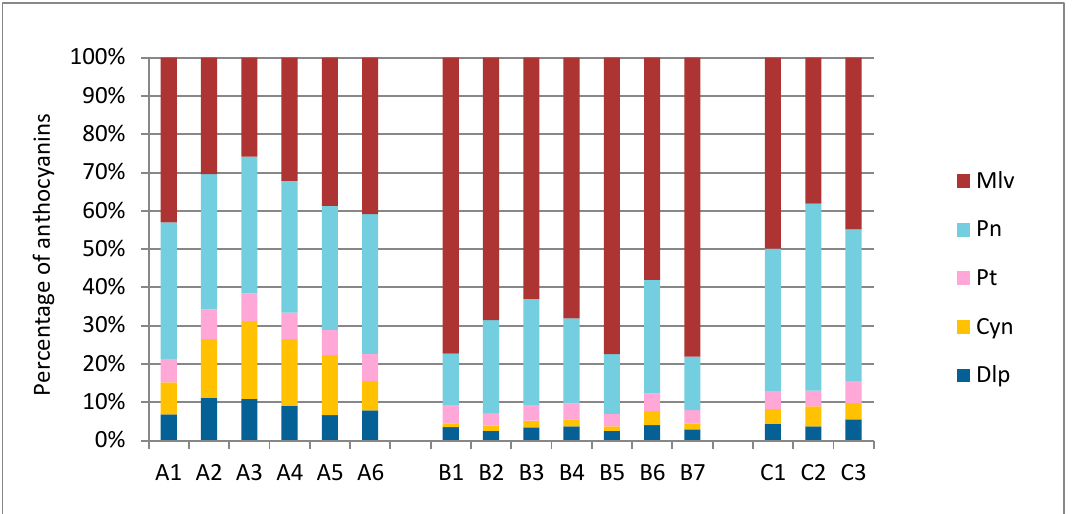
Figure 4. Percentage of individual anthocyanin content of Mlv; Pn; Cyn; Dlp; in the skins of the red grapes belonging to ‘Kotsifali’, ‘Limnio’, and ‘Vradiano’.